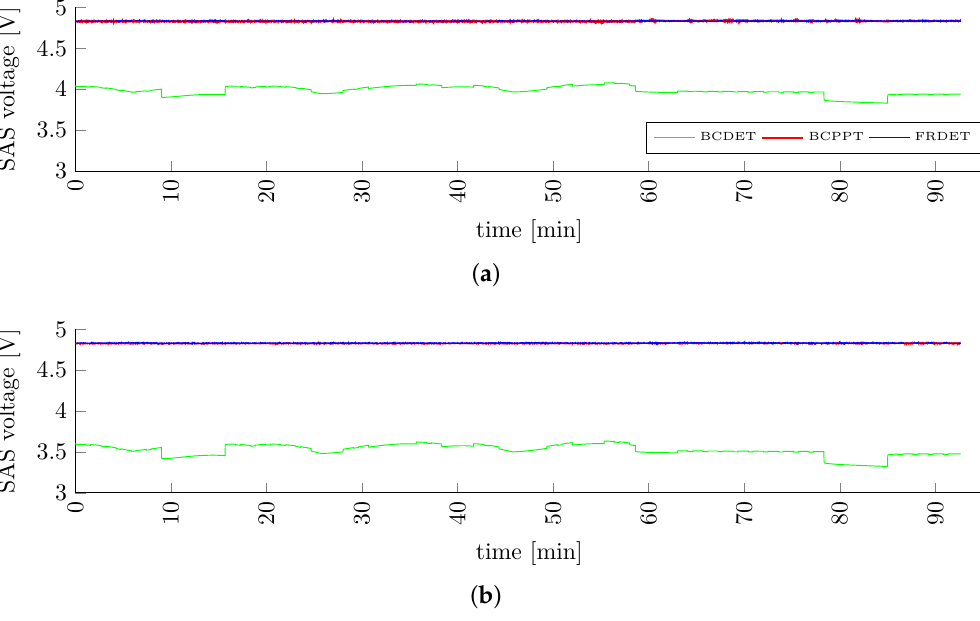
Figure 12. SAS voltage for initial OCV of: ( a ) 4.0V; ( b )